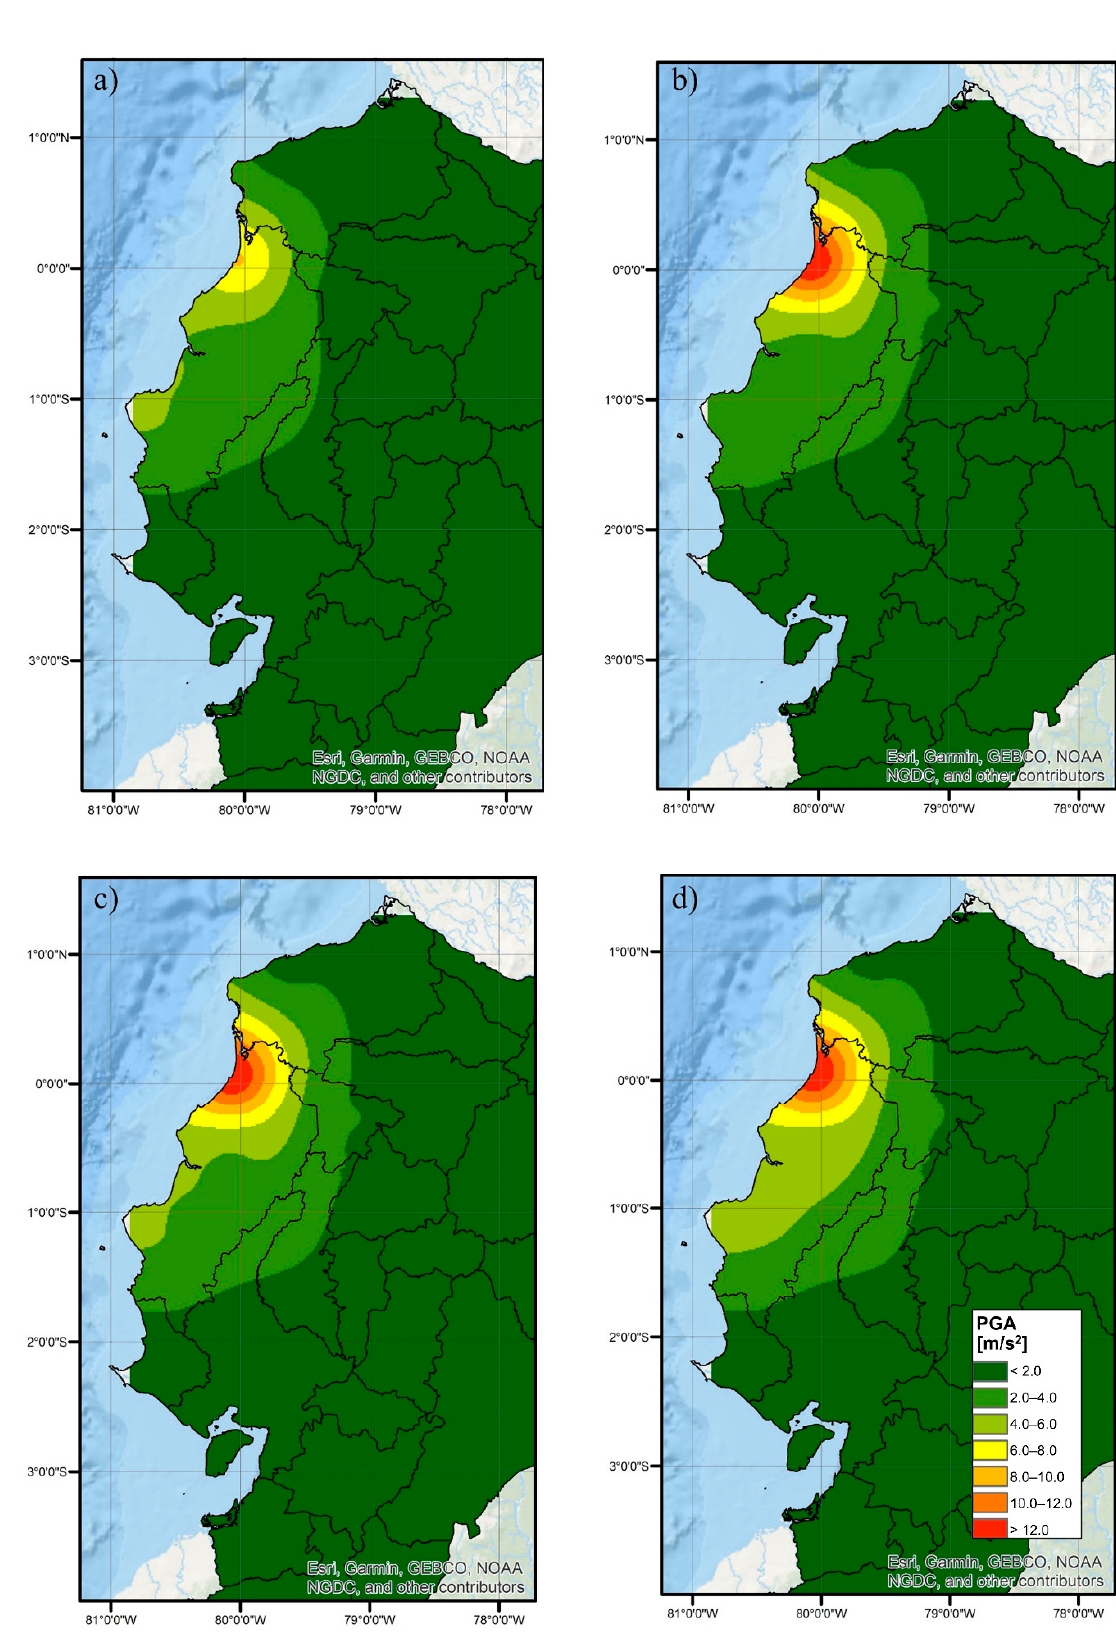
Figure 2. Peak ground acceleration maps of the as-recorded components ( a ) N-S and ( b ) E-W, ( c ) the larger value of the as-recorded components, and ( d ) the true peak acceleration ( PGA max ).